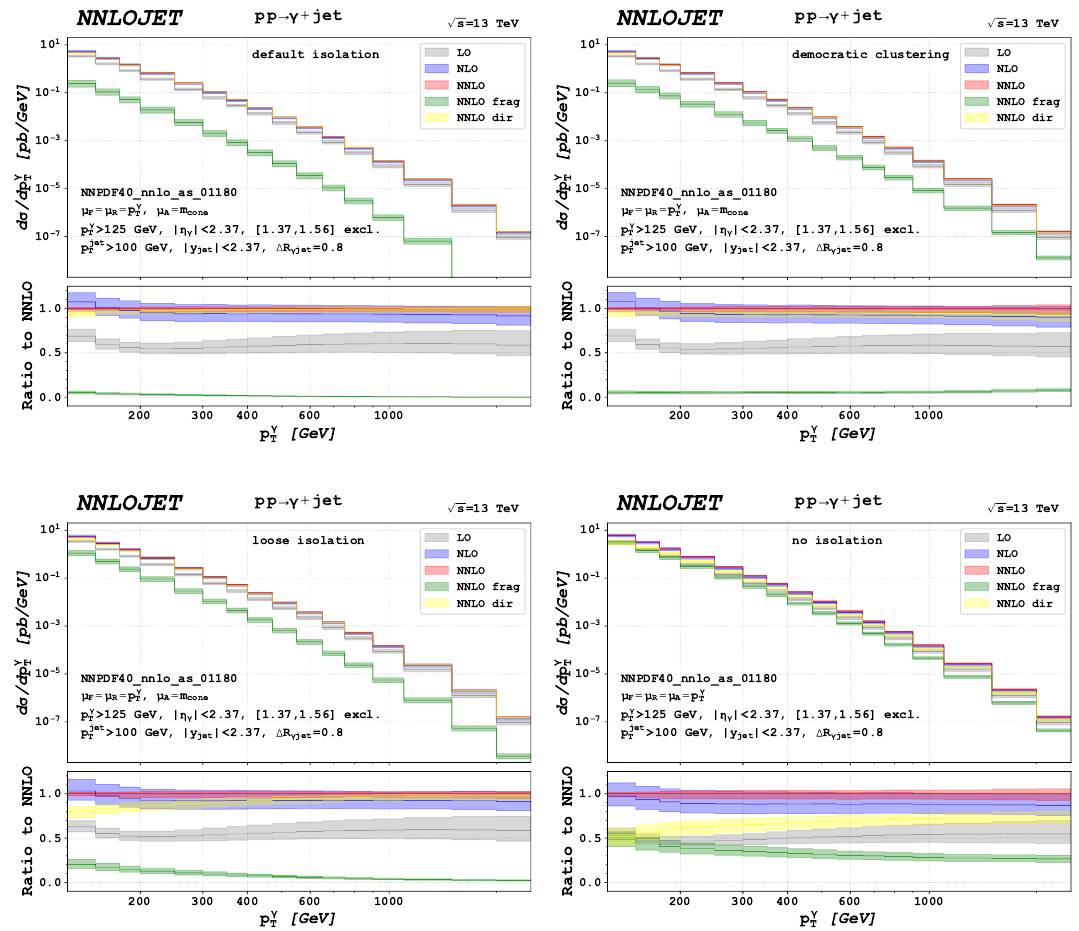
Figure 12. Decomposition of the cross section differential in the photon transverse momentum. Results obtained with the default isolation, a loose isolation, democratic clustering and without isolation are